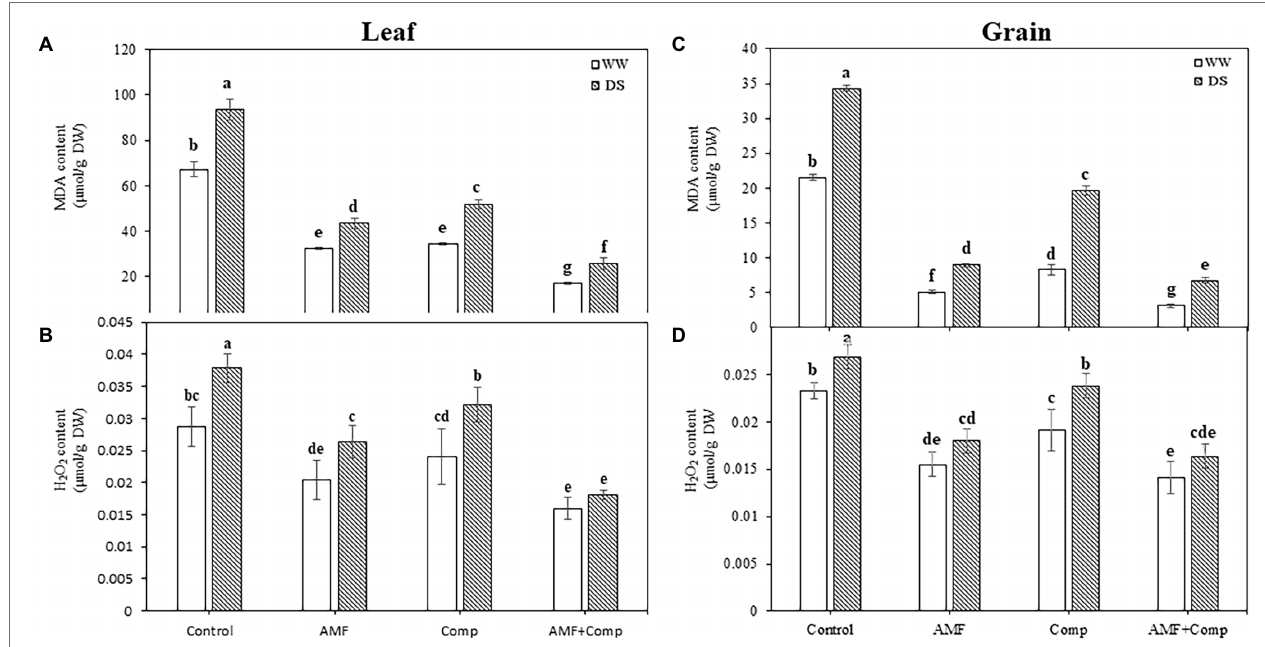
FIGURE 3 | Effects of water regimes (WW; well-watered or DS: drought stress) on leaves and seeds (A,C) lipid peroxidation (MDA) and (B,D) hydrogen peroxide (H 2 O 2 ) content in seeds of non-amended and non-inoculated quinoa (control), and quinoa inoculated with arbuscular mycorrhizal fungi (AMF) and/or amended with compost (Comp). Data are mean ± SD. Means followed by the same letters are not significantly different at p <